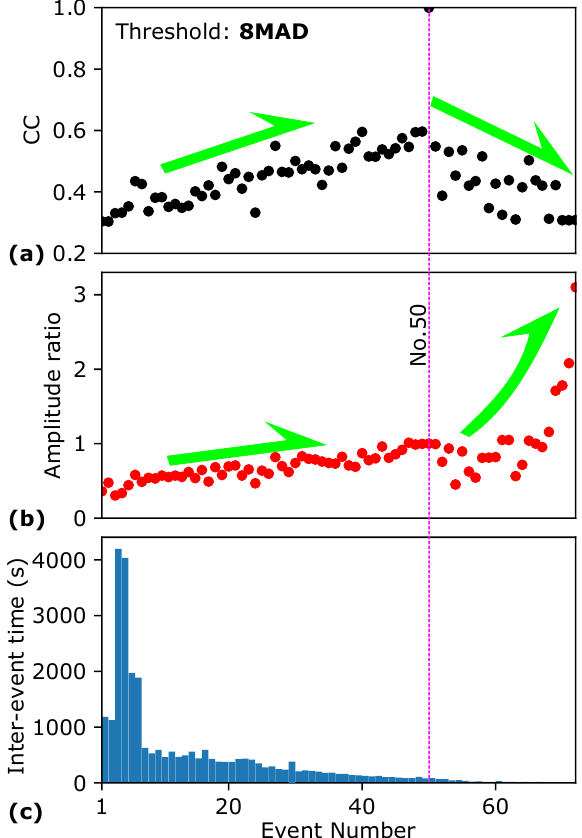
Figure 3. Characteristics of the seismic precursors. ( a ) CC values derived from MFMC. ( b ) Amplitude ratio of the seismic precursors with respect to the reference event No. 50. ( c ) Inter-event times of the seismic precursors. The dashed vertical fuchsia line marks the reference event (No. 50).